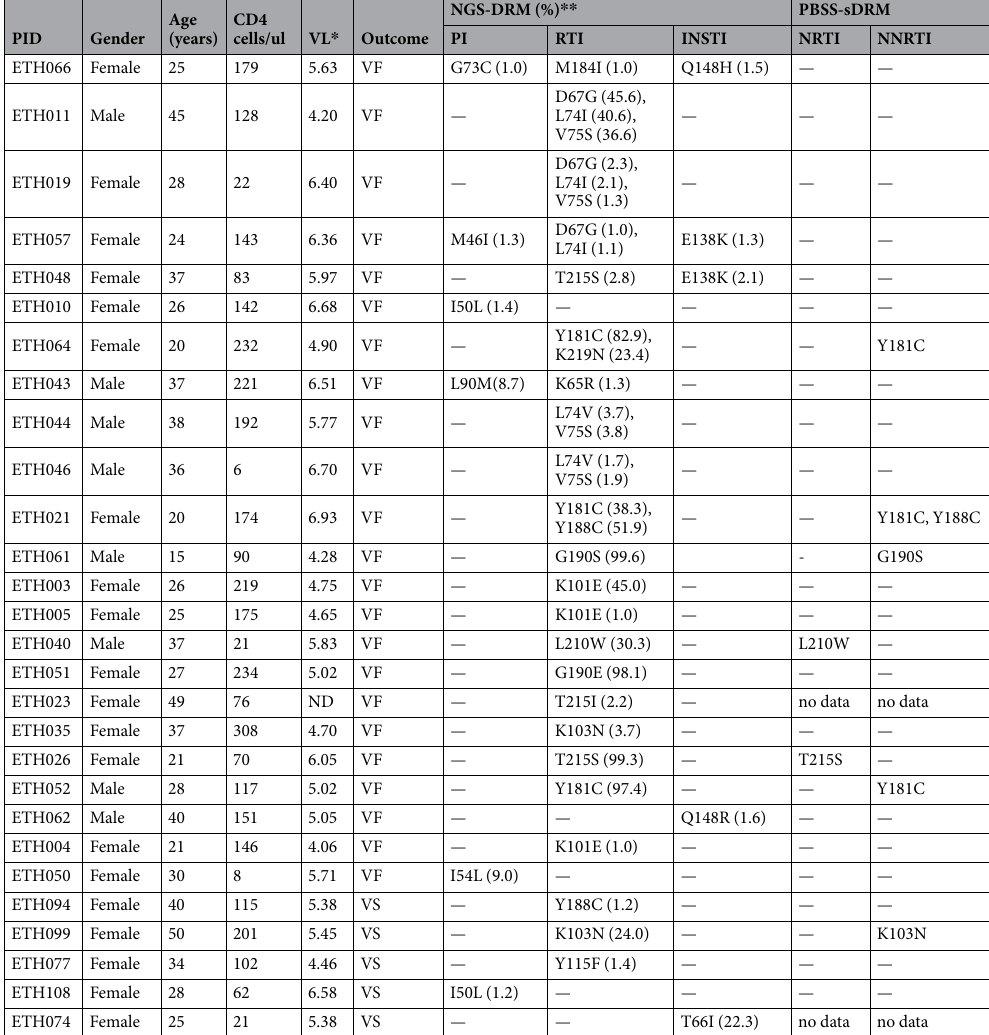
Table 3. Drug resistance mutations detected by next generation sequencing (NGS) or population based Sanger sequencing (PBSS) at baseline in 109 patients with virologic treatment failure (n = 71) or suppression (n = 38) at months six and/or 12. * VL: viral load, (log10 copies/ µ l); VF: virologic failure ( > 1000 copies/ml); VS: virologic suppressor < 2.18 log 10 copies/ml); ** DRM% = drug resistance mutations and the proportion of mutant virus. DRMs were identified for NRTI, NNRTI and PI based on the 2009 WHO list for surveillance of TDR and for INSTI the Stanford drug resistance summary list; —: no DRM